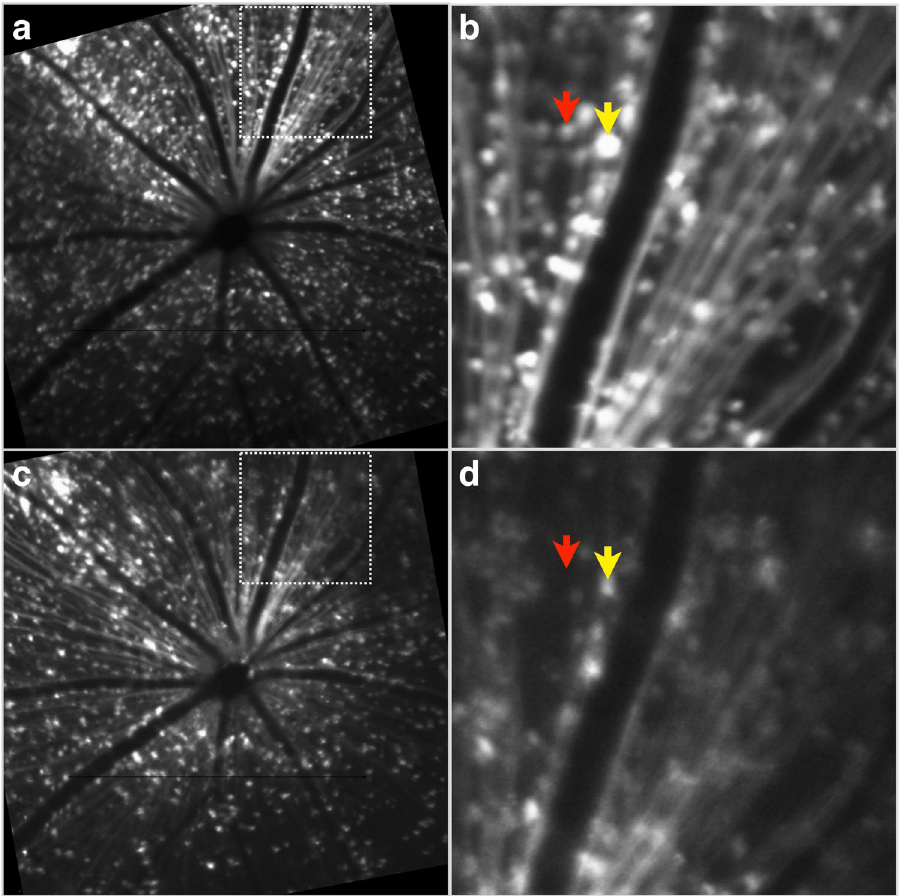
Figure 6. GFP labelling before and after optic nerve transection. In vivo fluorescence CLSO images from the same animal and retinal region, but at different time points, following optic nerve transection. ( a , b ) 5 weeks post-injection of the AAV2-DCX-GFP vector to label RGCs and ( c , d ) 14 days post-optic nerve transection to demonstrate the effects of RGC death on GFP labelling. Panels b and d are higher magnification views of the respective regions marked by boxes in panels a and c. Arrows indicate examples of a cell that has lost all fluorescence ( red ) and a cell with diminished fluorescence ( yellow